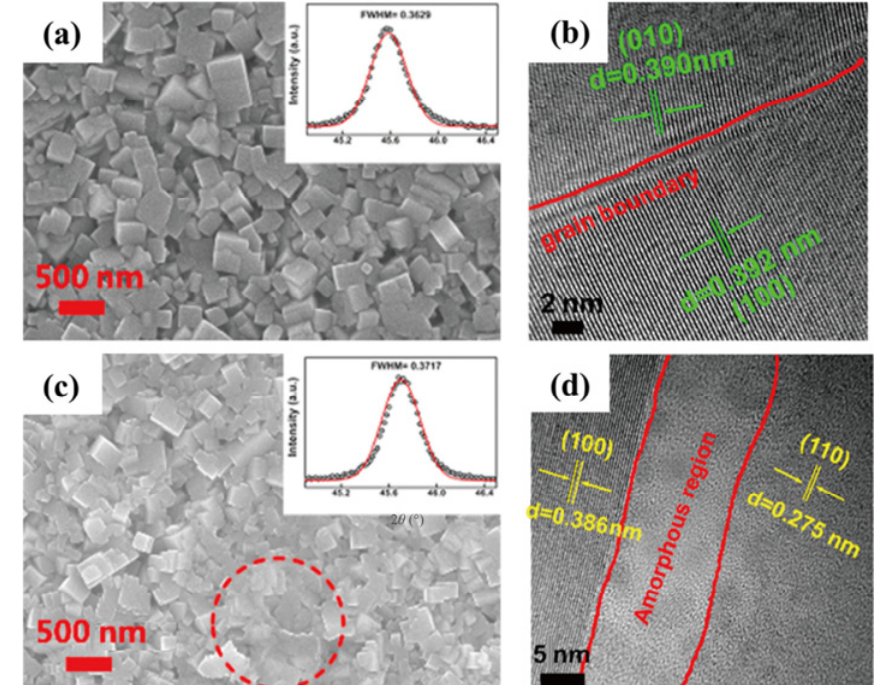
Fig. 20 SEM and high-resolution TEM (HRTEM) images of KNN–BZTN ceramics with different temperature and time: (a, b) 1130 ℃ , 15 h and (c, d) 1160 ℃ , 6 h. Note: FWHM means the full width at half maximum. Reproduced with permission from Ref. [164], © The Chinese Ceramic Society